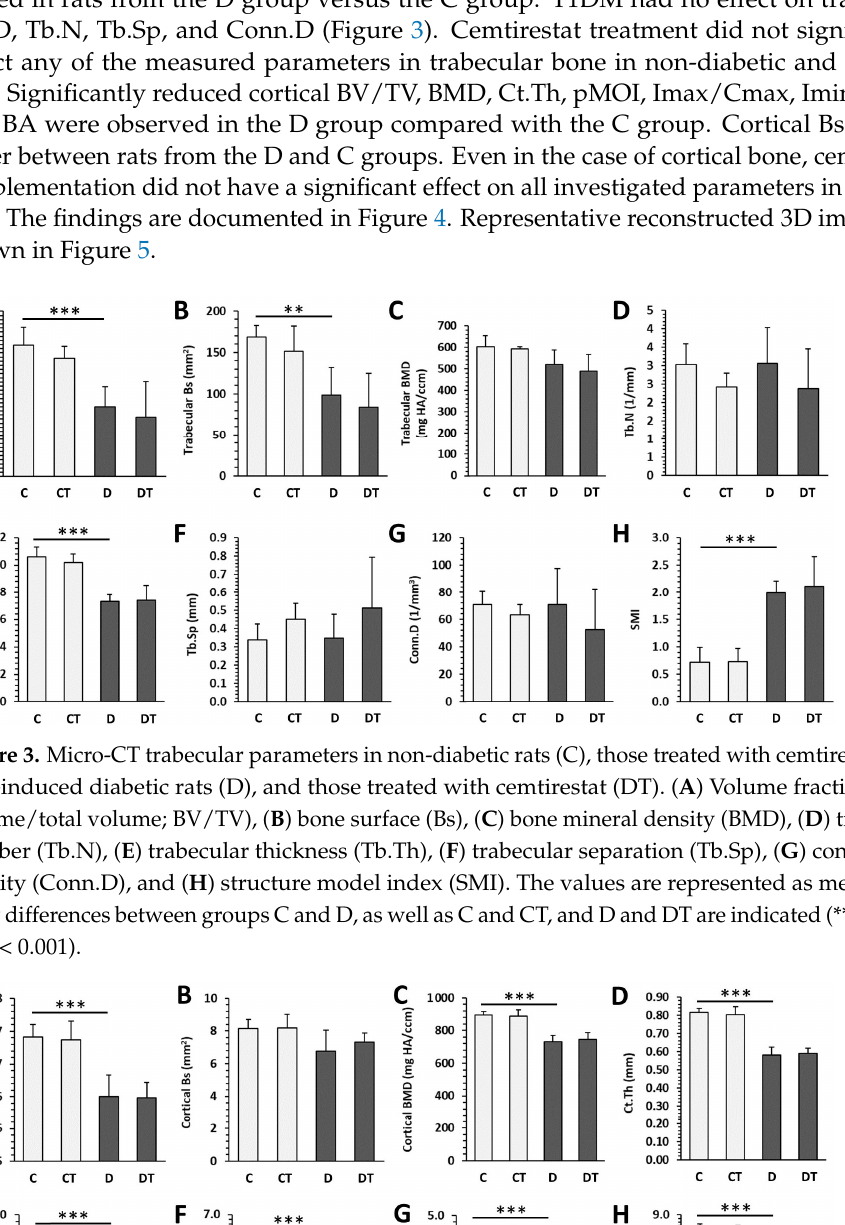
Signi fi cantly decreased trabecular BV/TV, Bs, Tb.Th and increased SMI were deter- mined in rats from the D group versus the C group. T1DM had no e ff ect on trabecular BMD, Tb.N, Tb.Sp, and Conn.D (Figure 3). Cemtirestat treatment did not signi fi cantly af-